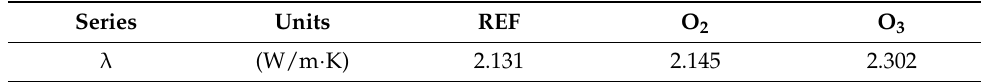
Table 7. Thermal conductivity coefficient of concretes.